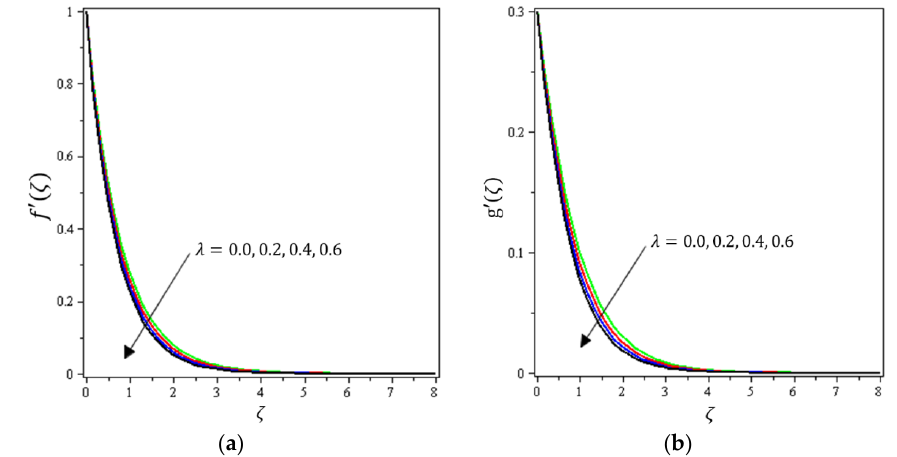
Figure 4. Influence of permeability parameter 𝜆 on velocities ( a ) 𝑓′(𝜁) and ( b ) g ′(𝜁) .